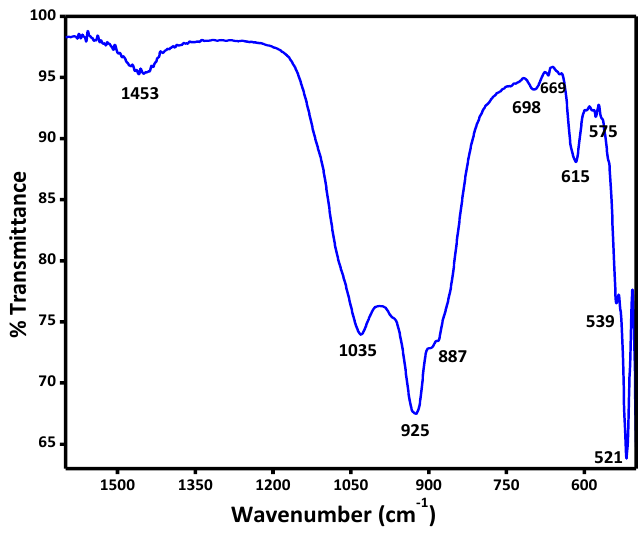
Figure 3. FTIR Spectrum of Sol-Gel Derived 45S5